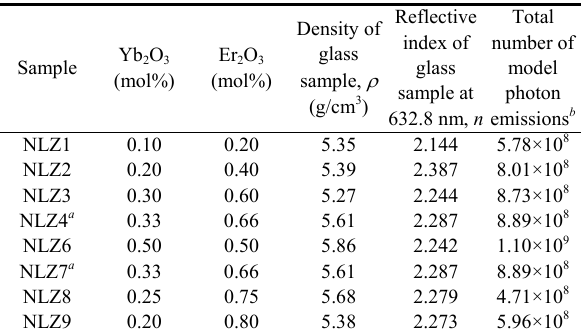
Table 1 Composition, density, and refractive index of Er 3+ /Yb 3+ codoped NLZ1–9 glass samples